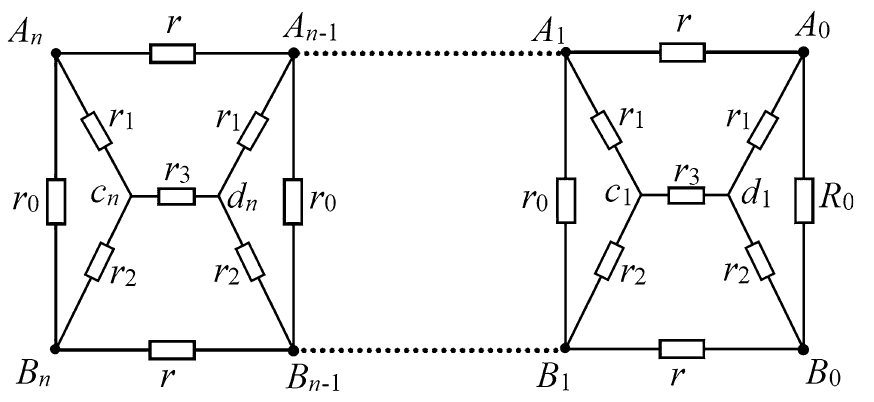
Figure 1. An n -bridge circuit network model with 6 different resistance